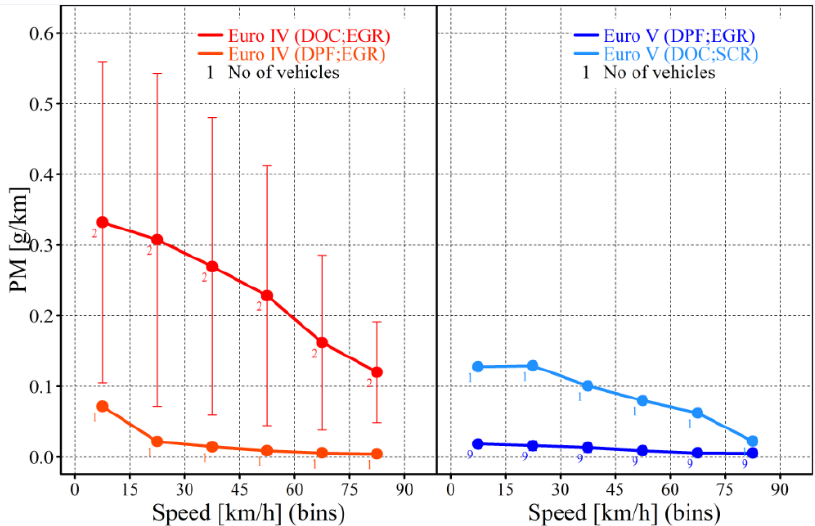
Figure A1. Sample mean and ± one standard error limits of the distance-based PM emission levels over speed (500 m driving sequences).